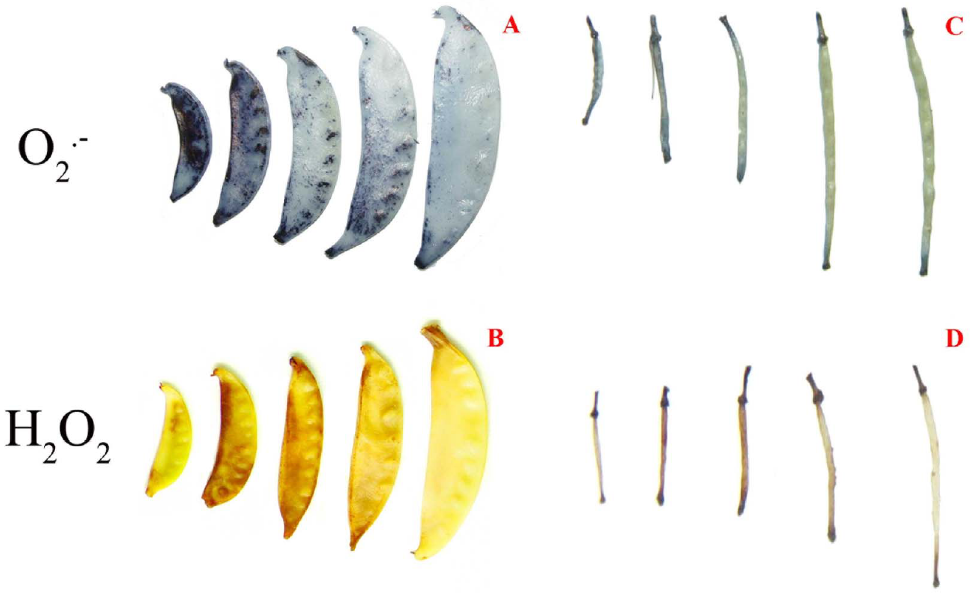
Figure 3. Visualization of reactive oxygen species in pods. O 2 . 2 (A, C) and H 2 O 2 (B, D) in pods of P. sativum (A,B) and B. chinensis (C, D) were detected at five developmental stages. A sample was collected from both species during each stage of pod development; these samples consisted of five pods, and each pod was separately collected from a different plant.O 2 . 2 and H 2 O 2 were detected by NBT and DAB staining, respectively.